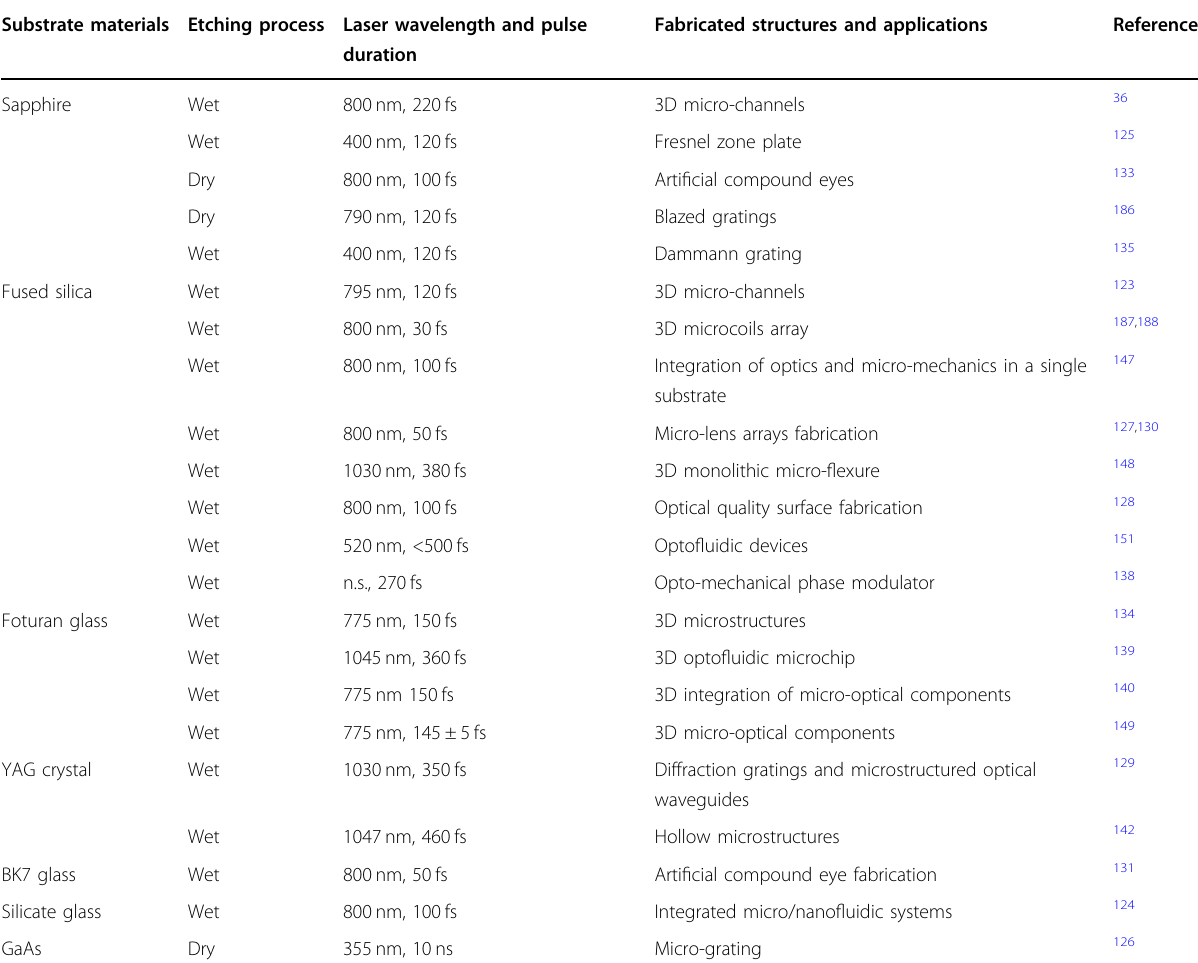
Table 3 Experimental reports of the etching-assisted laser micromachining technology on different transparent